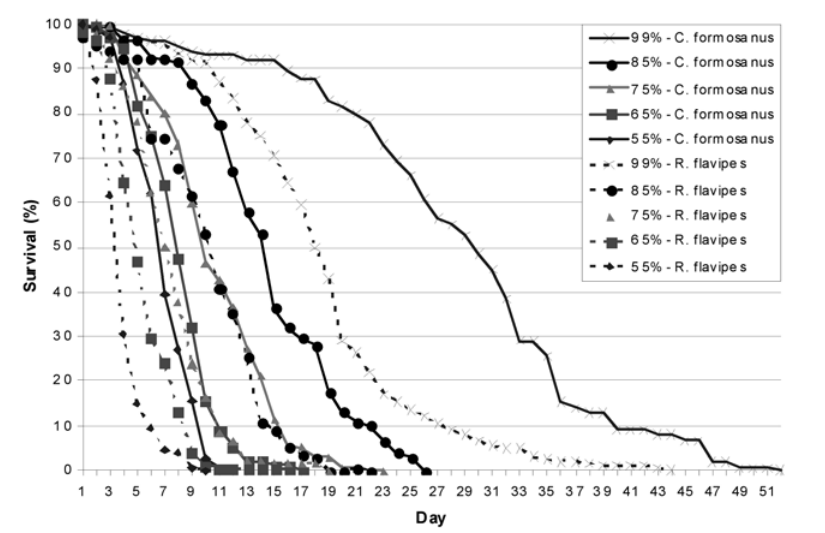
Fig. 1. Survival of small groups (18 workers + 2 soldiers) of C. formosanus and R. flavipes at 10 ° C and varying relative humidities.